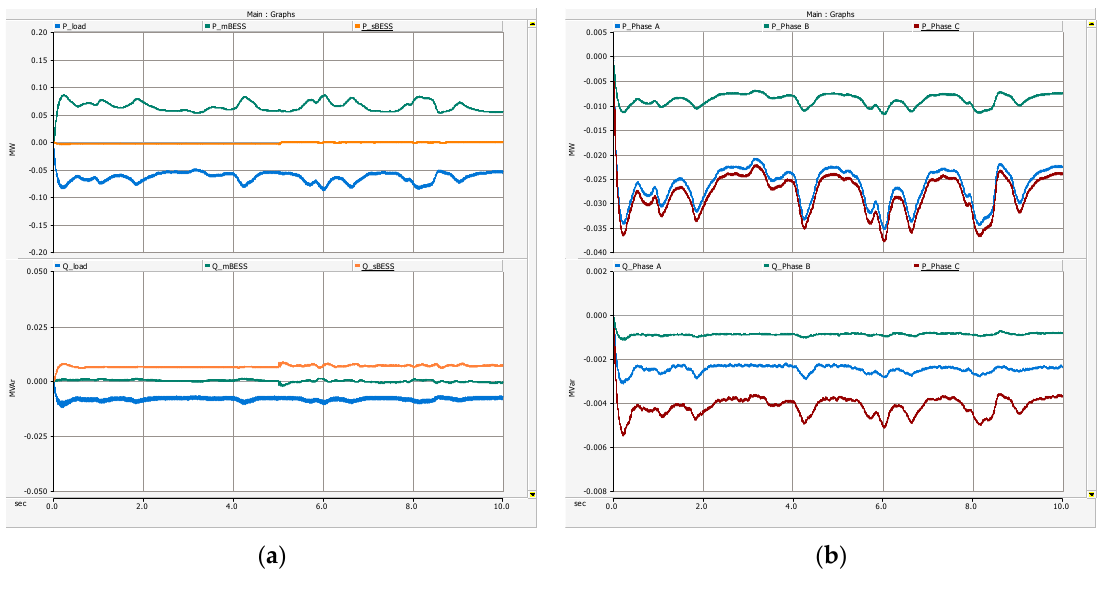
Figure 15. Simulation results of Scenario 2 ( a ) Whole power system (top: active power; bottom: reactive power) and ( b ) load demand (top: active power for each phase; bottom: reactive power for each phase).